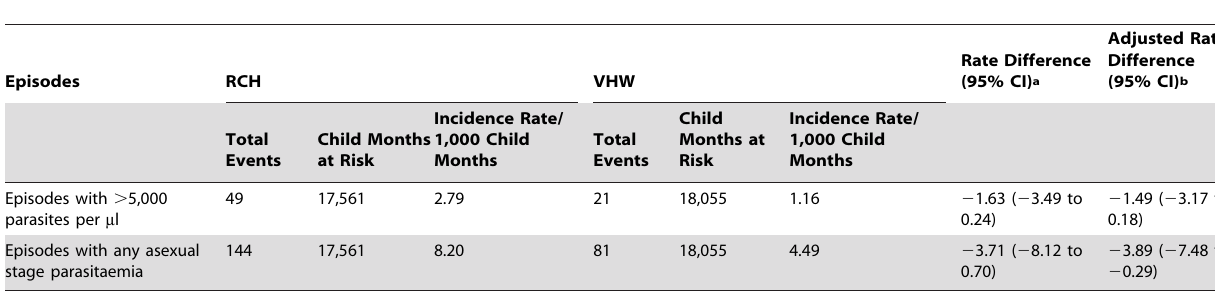
Table 3. Incidence of clinical episodes of malaria in the two study groups.